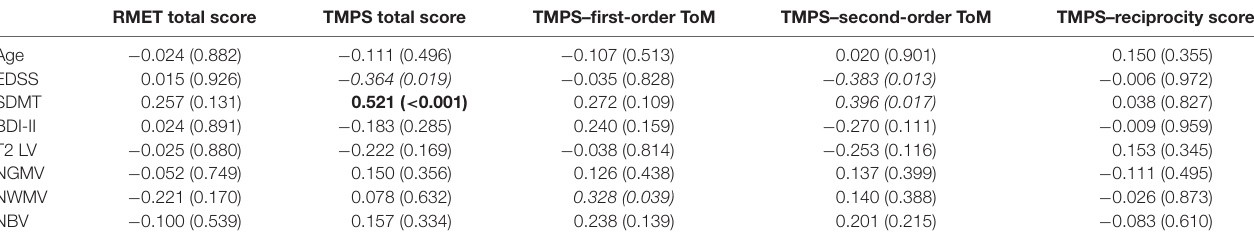
TABLE 2 | Associations between social cognition measures and clinical, neuropsychological, and MRI data in the MS sample.